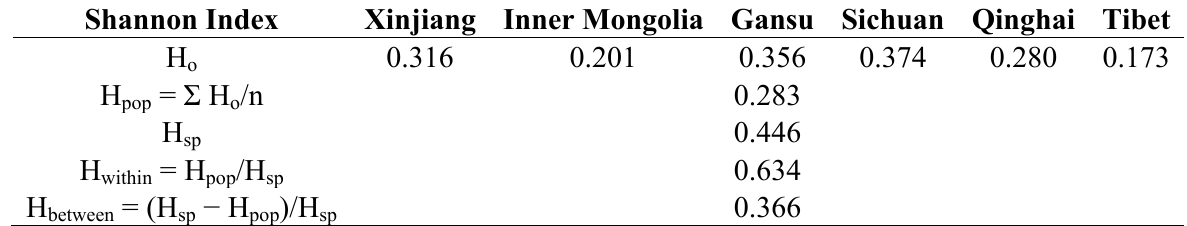
Table 4. Shannon-weaver diversity indices for six Chinese geographic